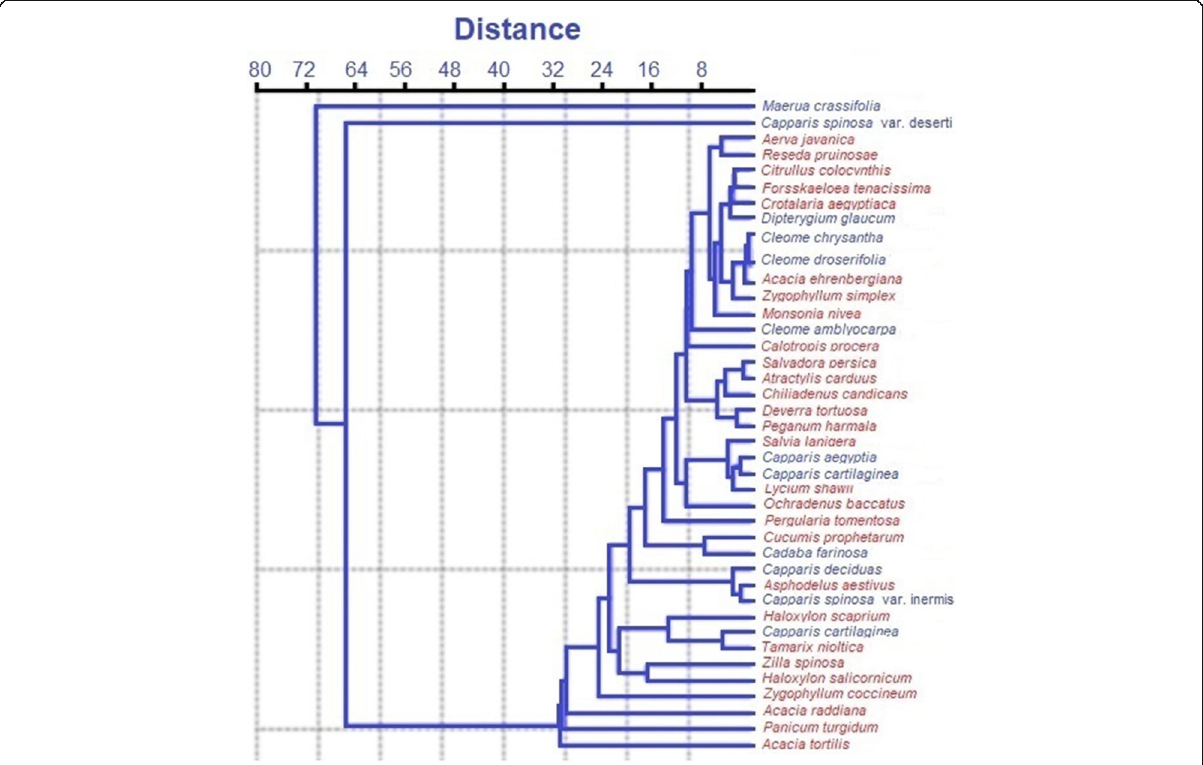
Fig. 3 The tree represents the classification of the twelve selected Capparaceae and Cleomaceae species of the study, in blue, together with the 29 accompanying species in